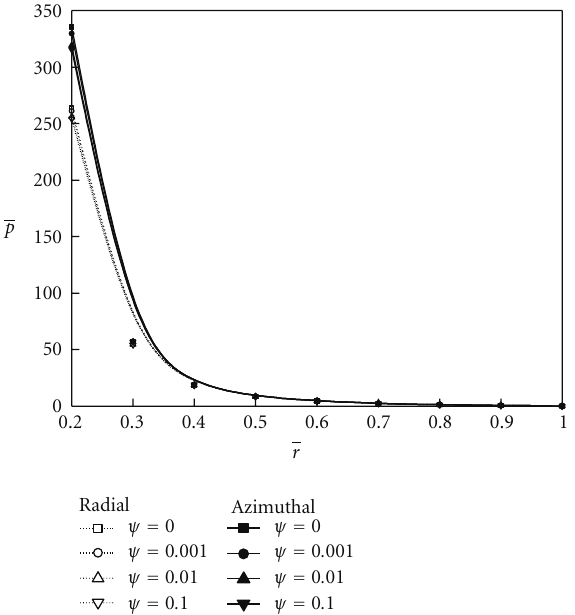
Figure 7: Variation of nondimensional mean load-carrying capac- ity W with M for di ff erent values of l with β = 0 . 05, c = 0 . 3, and ψ = 0 .